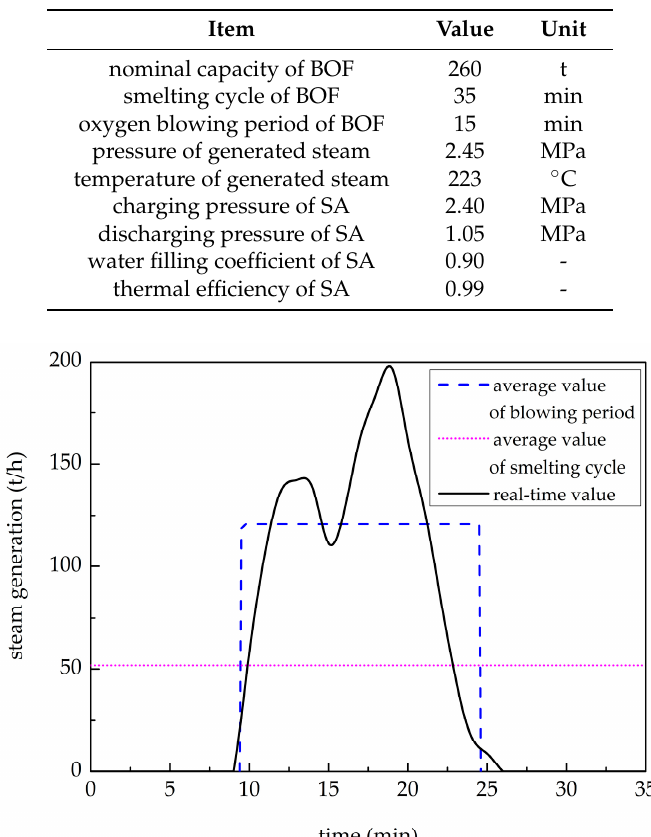
Table 2. Parameters of basic oxygen furnaces (BOFs), steam accumulators (SAs), and generated steam.